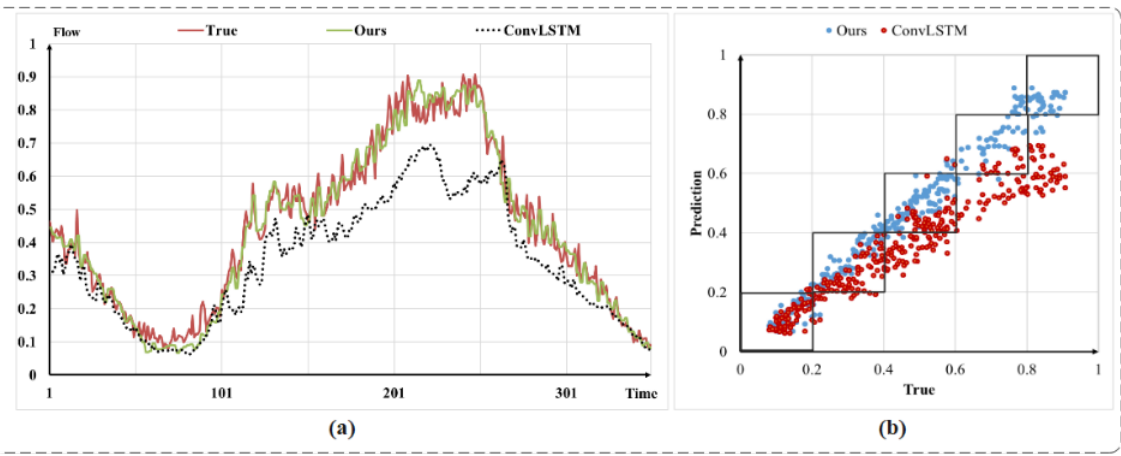
Figure 8. Comparative effect of DSGCN and ConvLSTM predictions. ( a ) is a time-series variation plot. ( b ) is a numerical scatter plot. plot. ( b ) is a numerical scatter